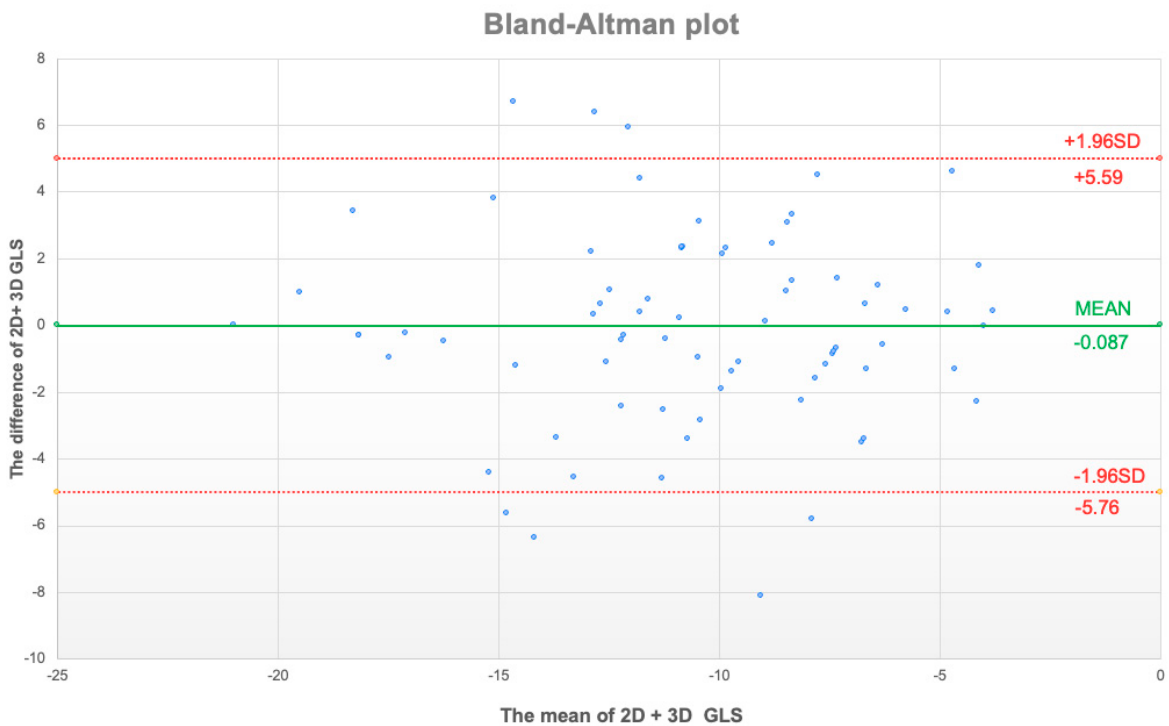
Figure 4. Bland–Altman plot of mean values of 2D + 3D global longitudinal strain (GLS, x axis) and the difference between 2D and 3D GLS. Upper and lower limit of agreement displayed as red dotted line with respective values.